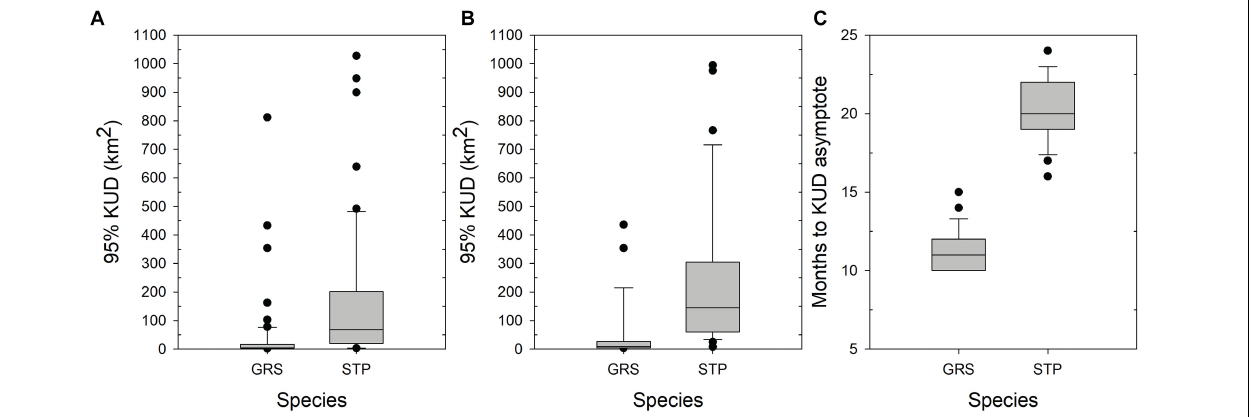
FIGURE 4 | Estimates of space use (95% KUD) from the dynamic Brownian Bridge movement model (dBBMM) applied to acoustically tagged Grey Reef (GRS) and Silvertip Sharks (STP). (A) Total space use of all acoustically tagged sharks based on cumulative monthly estimates of 95% KUD. (B) Total space use of subset of tagged sharks based on non-linear mixed effect models applied to a monthly cumulative estimates of 95% KUD for sharks with monitoring periods > 5 months. (C) Estimated number of months to reach an asymptote in monthly cumulative estimates of 95% KUD based on the non-linear mixed effect model.